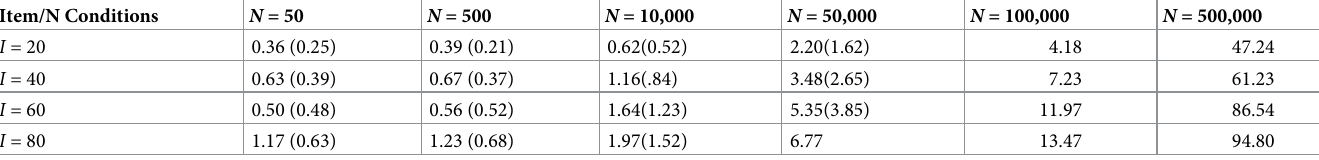
Table 1. Uni-dimensional Rasch report computational time (in